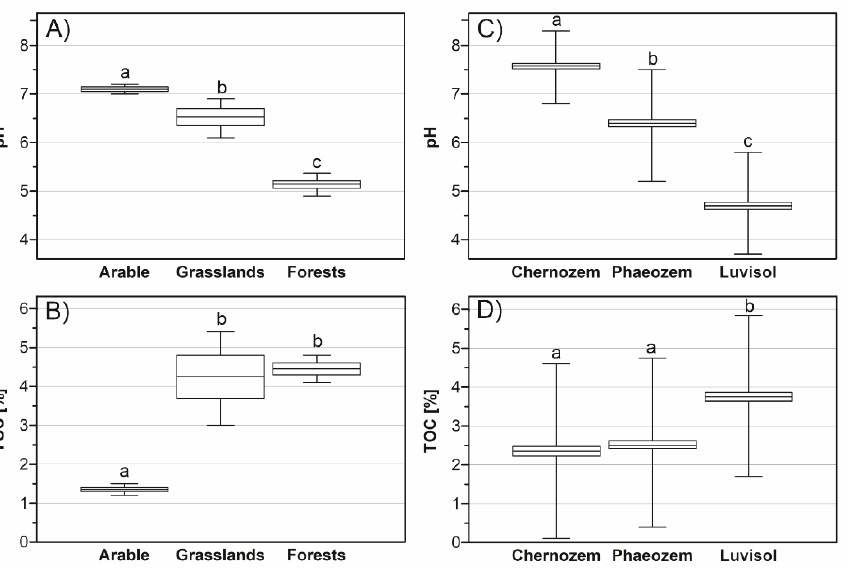
Figure 3. Basic properties of topsoil layers in the distinguished classes of land use: ( A ) soil pH, ( B ) SOC content, and soil type: ( C ) soil pH, ( D ) SOC content. Explanation: SOC—soil organic carbon; horizontal line—mean value, box—standard error, whiskers—standard deviation. Categories with the same letters (a, b) are not significantly different (Fisher test at p < 0.05) for the particular soil property.